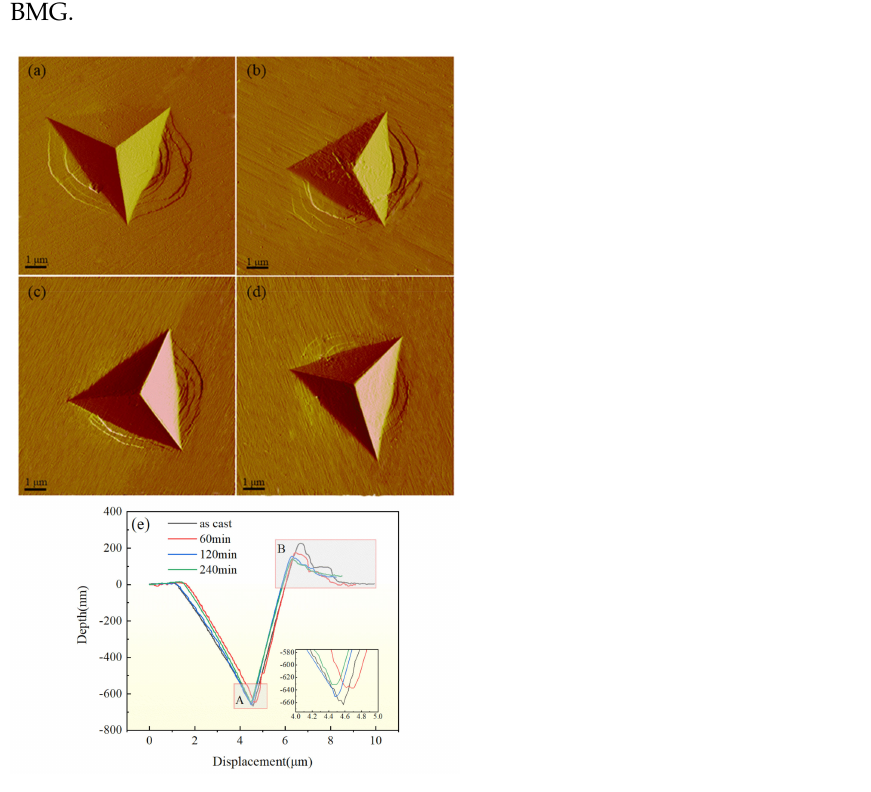
Figure 6. ( a – d ) Indentation morphology of the as-cast and annealed La 65 Al 14 Ni 5 Co 5 Cu 9.2 Ag 1.8 BMG: ( a ) as-cast; ( b ) 60 min; ( c ) 120 min; ( d ) 240 min; ( e ) Depth-displacement